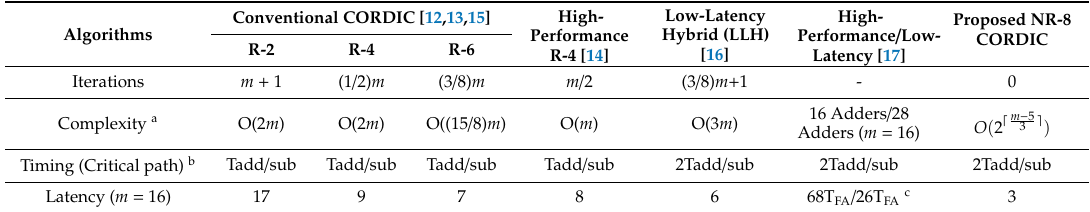
Table 3. Performance comparison of newly developed CORDIC algorithms with m -bit precision. Algorithms